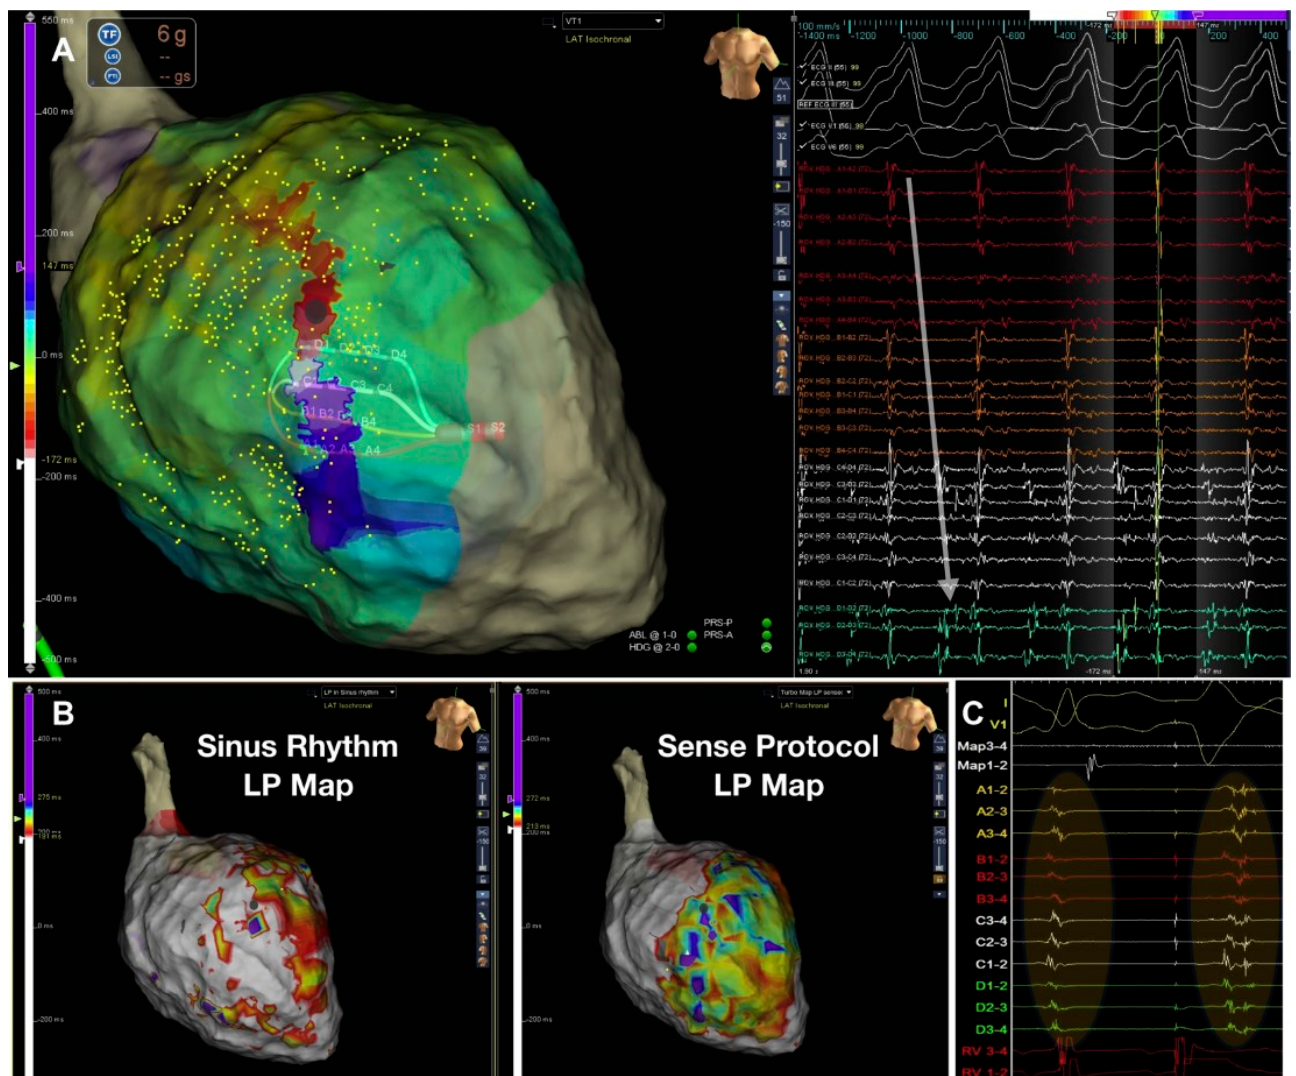
Figure 3. Figure adapted from Srinivasan et al. [35] illustrating the Barts’ sensed protocol. ( A ) shows a high-density VT activation map. ( B ) illustrates the 2 activation maps during sinus rhythm (left) with a late potential (LP) color timing map and the activation time during the sensed RV pacing beat (( B ) right) showing a greater region of LPs during Bart-sense-protocol colocalizing to a greater extent with the mapped isthmus of the induced VT ( A ). ( C ) shows delay and splitting of LPs during sense protocol (second beat) is observed within the region of the diastolic pathway of VT.